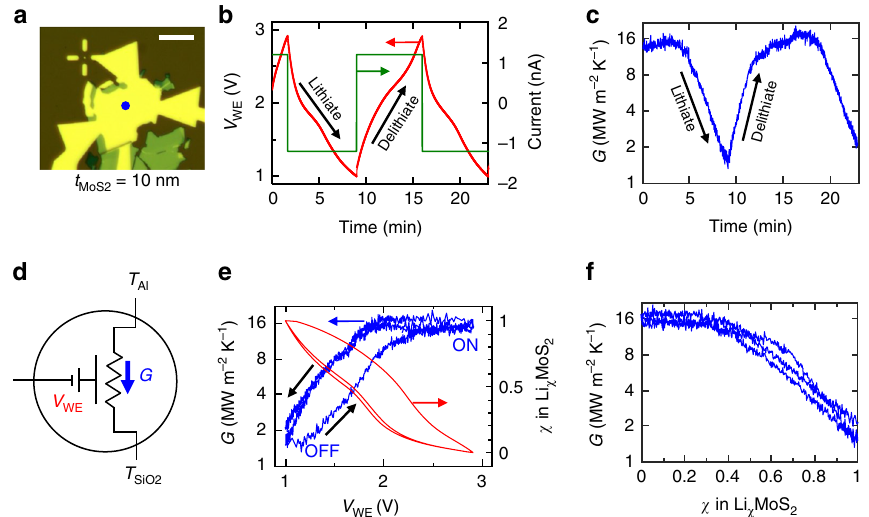
Fig. 3 Thermal transistor characteristics. a Optical micrograph of the device showing the location of real-time TDTR measurements (blue circle). The scale bar is 10 µ m. b Galvanostatic characteristics, obtained using an applied (dis)charge current of ( − ) + 1.2 nA (shown in green). The resulting voltage curves are shown in red, taken within fi xed limits of 1.0 V and 2.9 V. c Cross-plane thermal conductance measured during the electrochemical cycle shown in b . d Circuit diagram of the thermal transistor device: the gating voltage V WE ) that is applied between Li and Al/MoS 2 electrodes changes the thermal conductance G ) to heat fl ow between the Al transducer and SiO 2 substrate, which are at temperatures T Al and T SiO2 respectively. e Thermal conductance and average lithium composition χ plotted vs. voltage, showing signi fi cant hysteresis between charge and discharge curves. f G plotted against